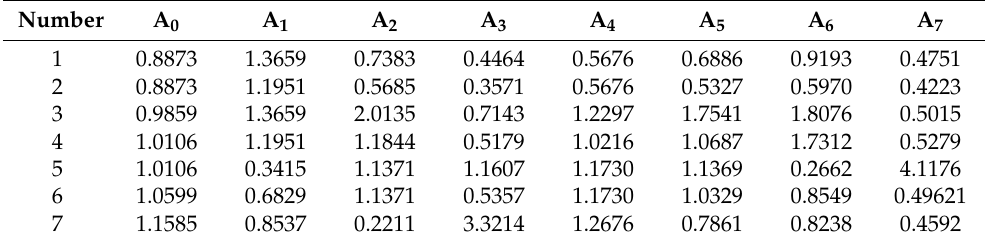
Table 3. Data on factors influencing surface subsidence in Lu’an mine after dimensionless